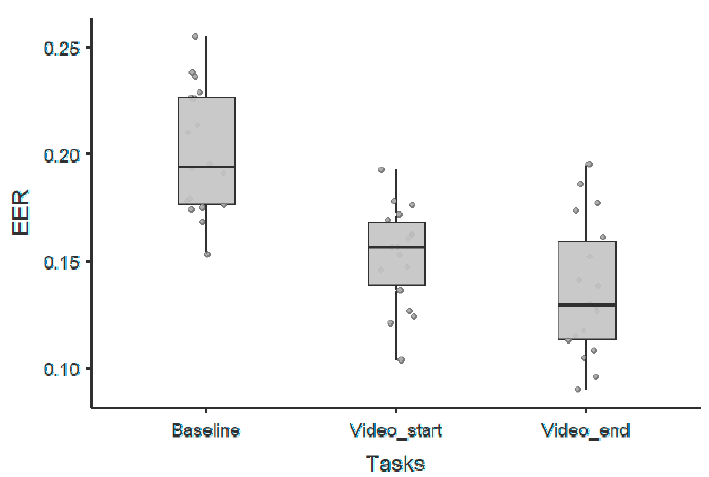
Figure 4. Scatter-plots represent the EERs for each experimental condition for the beta frequency band. Table 3. Statistical analysis for the beta band.